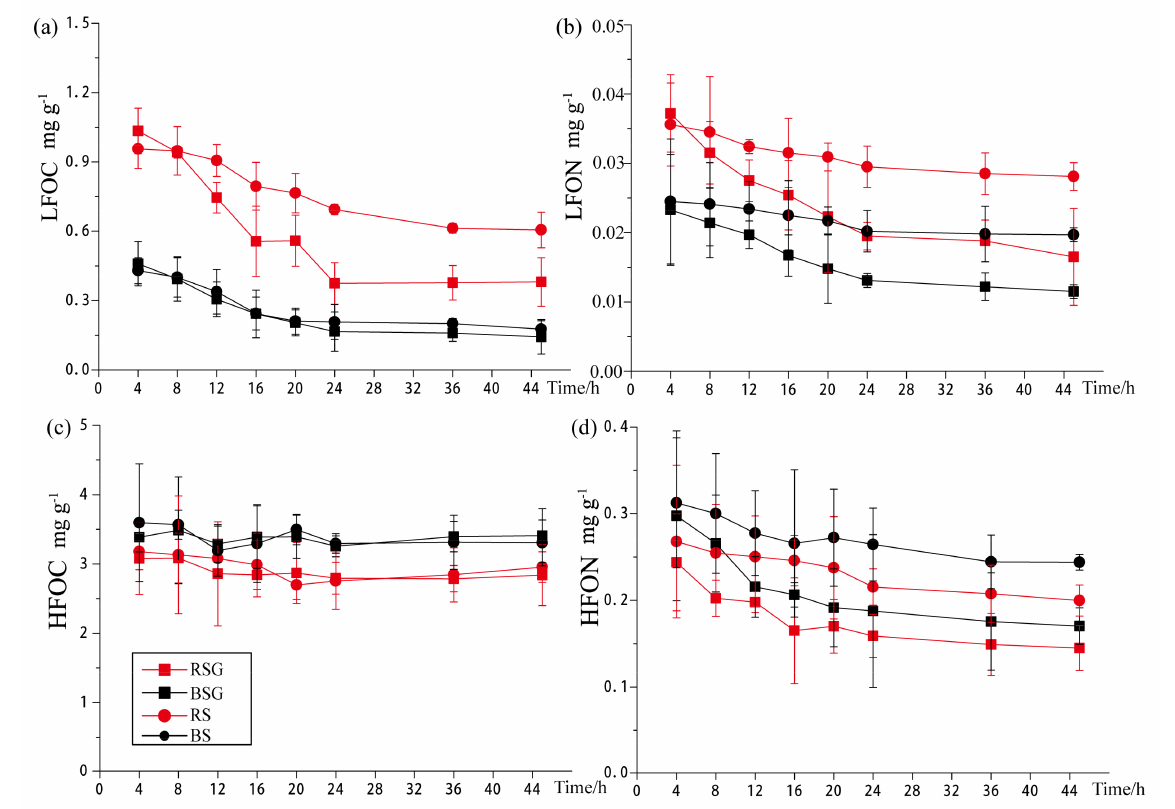
Figure 3. The changes of C and N fractions. Among which, ( a , b ) indicated the light fraction organic carbon (LFOC) and nitrogen (LFON), and ( c , d ) showed the heavy fraction organic carbon (HFOC) and nitrogen (HFON) in the wetland pots (mg · g − 1